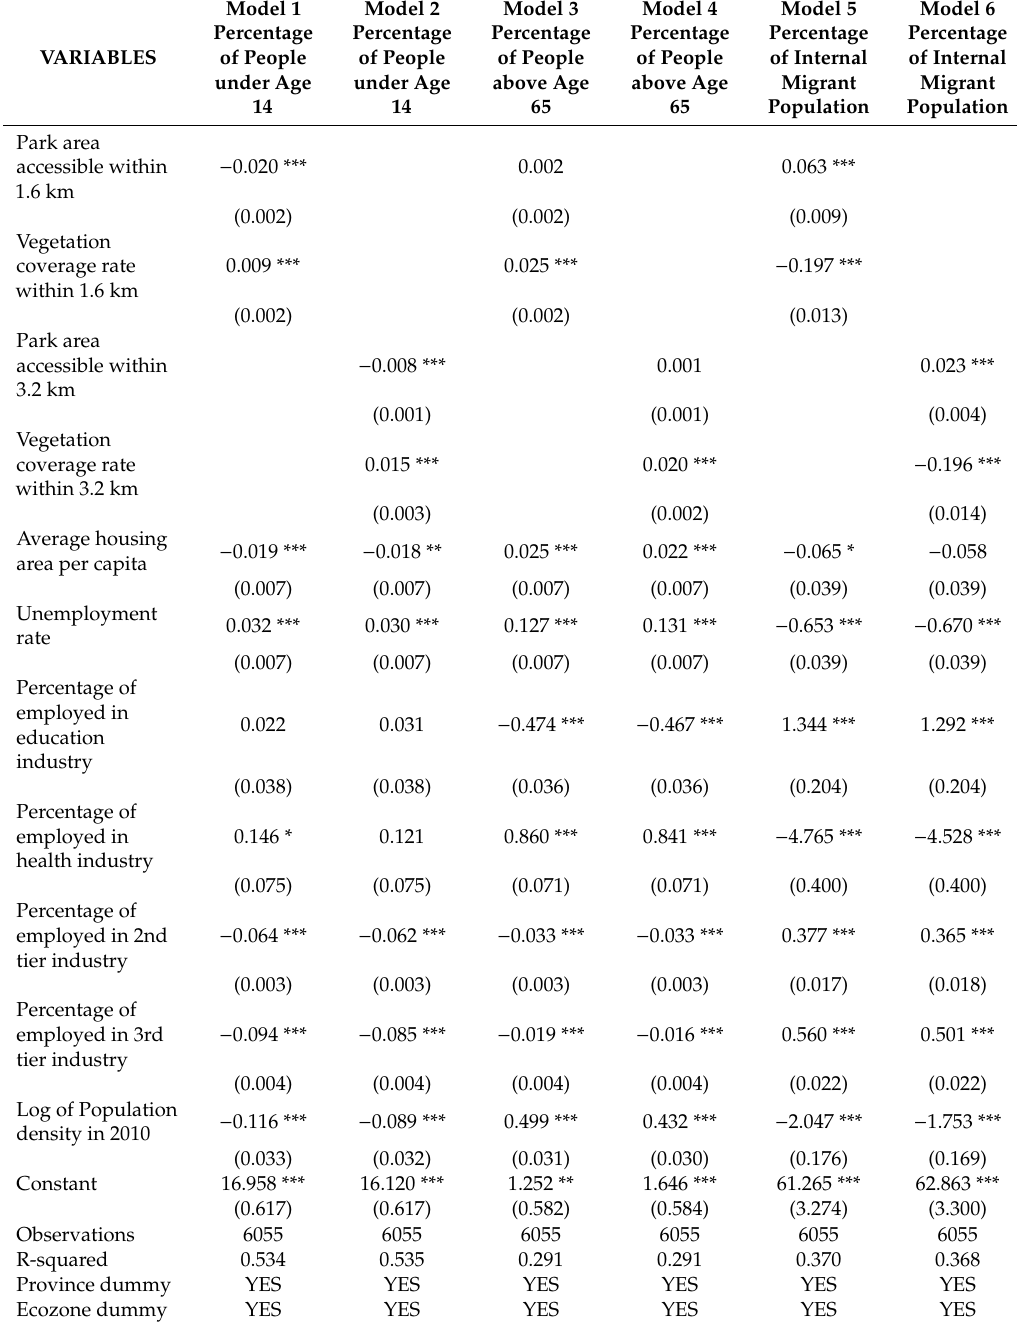
Table 2. Regression analysis for entire